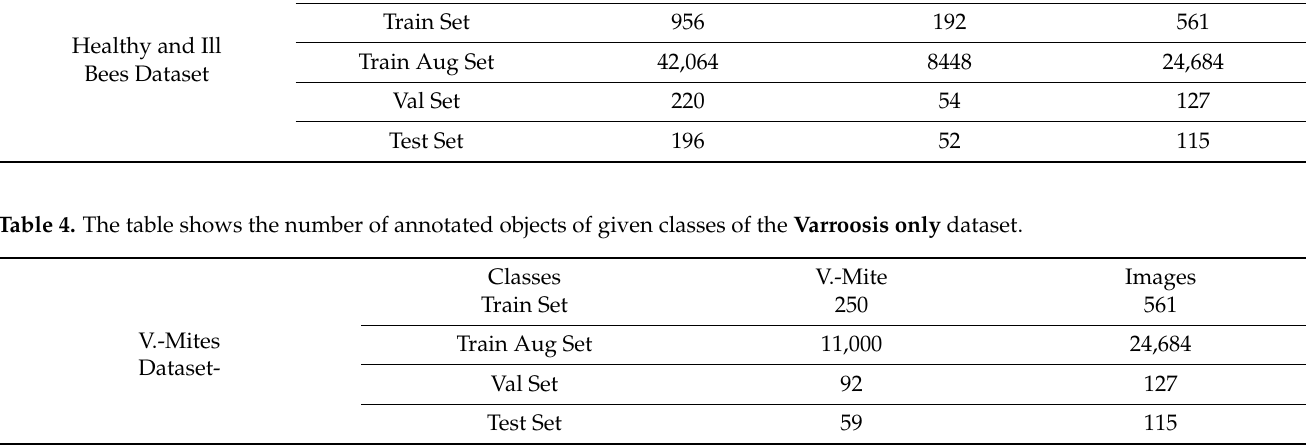
Healthy and Ill